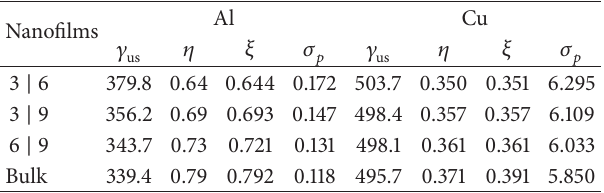
Table 2: The unstable stacking fault energy 𝛾 us (in units of mJ/m 2 ), core structure parameter 𝜂 , core width 𝜉 (in units of 𝑏 ), and Peierls stress 𝜎 𝑝 (in units of 𝜇 ) of the (1/2)⟨110⟩{111} screw dislocations in Al and Cu